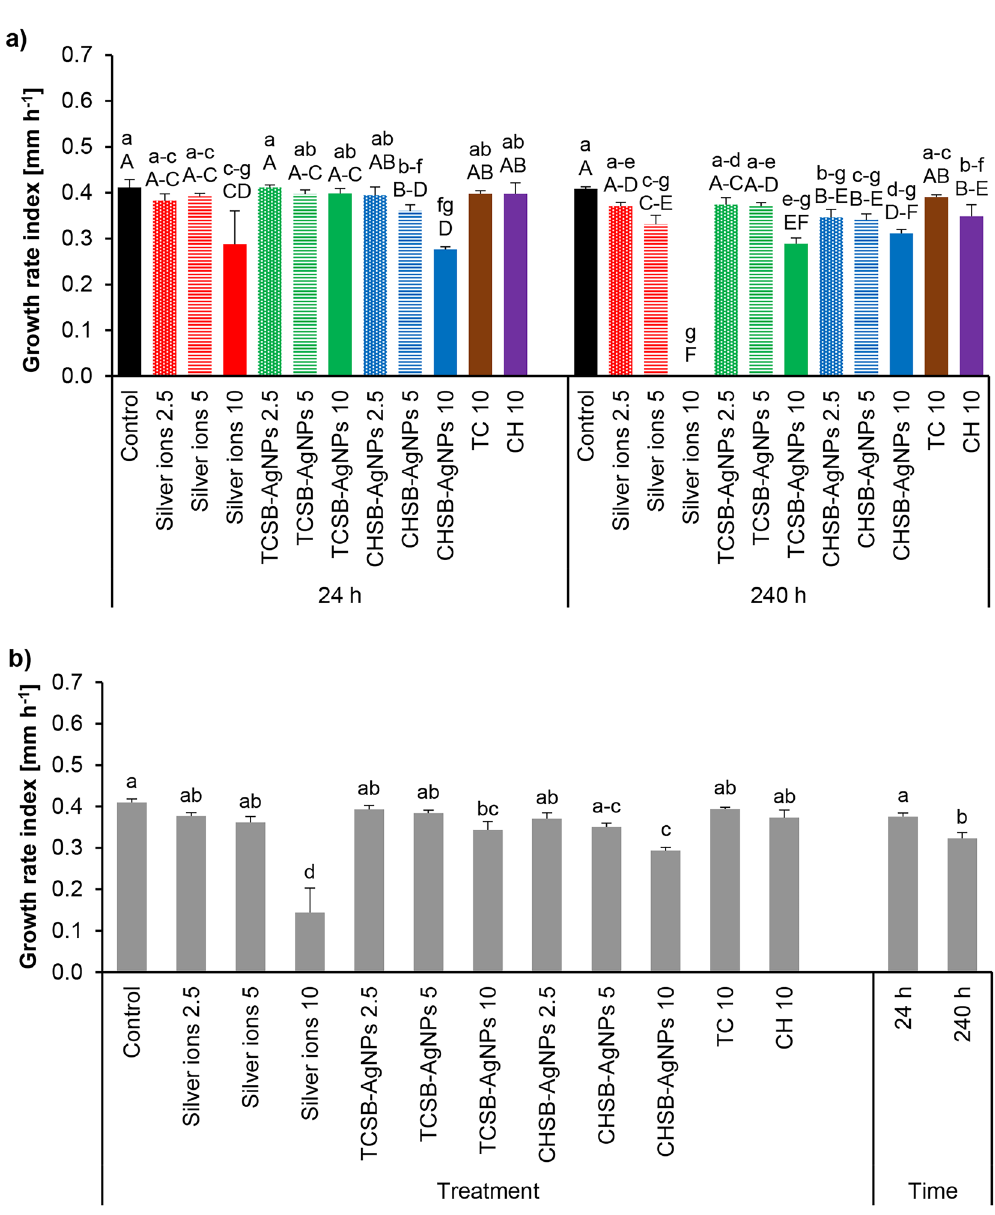
Figure 4. The impact of silver ions, AgNPs and stabilizing agents on the mycelium growth rate index of F. equiseti after culture over 24 h and 240 h of the exposure period: factors interaction effect ( a ), factors effect ( b ). Data represents mean values ± SE. Values marked with the same letters (lowercase letters for the interaction effect, as well as the main effects of time and treatment; capital letters for interaction effect separately for the hours) are not significantly different at p ≤ 0.05. The number given for each treatment represents the concentration expressed in mg L −1